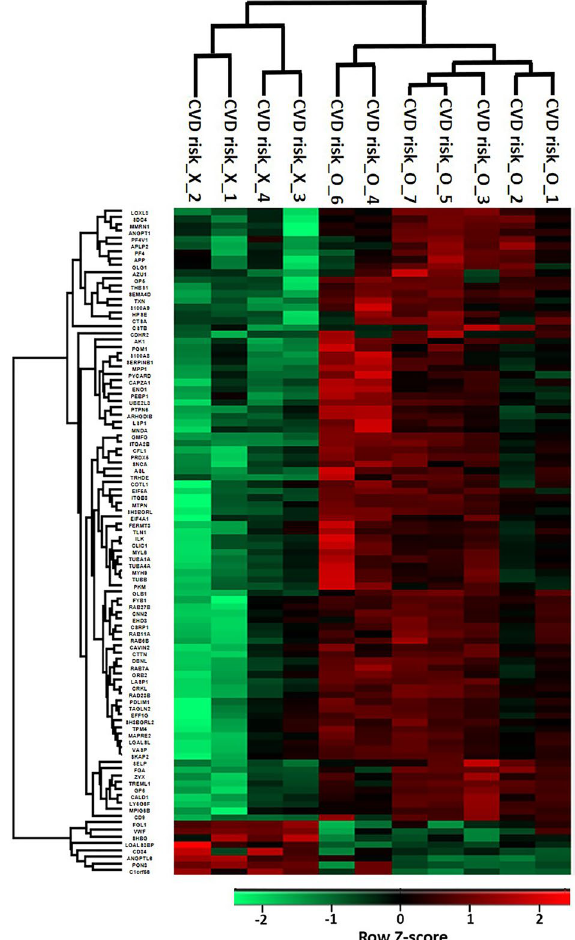
Figure 1. Heat map exhibiting hierarchical clustering of 98 proteins with statistically significant changes (> 2.0-fold, P-value < 0.05 from ANOVA followed by Scheffe’s post-hoc analysis) between psoriasis groups with and without cardio vascular disease (CVD) risk factors. The rows represent each protein and the columns show four and seven biological replicates of psoriasis serum samples without and with CVD risk factors, respectively. Hierarchical clustering of the 98 proteins was performed in Perseus software (1.6.14.0) on log-transformed normalized signal-to-noise ratio values after z-score normalization of the